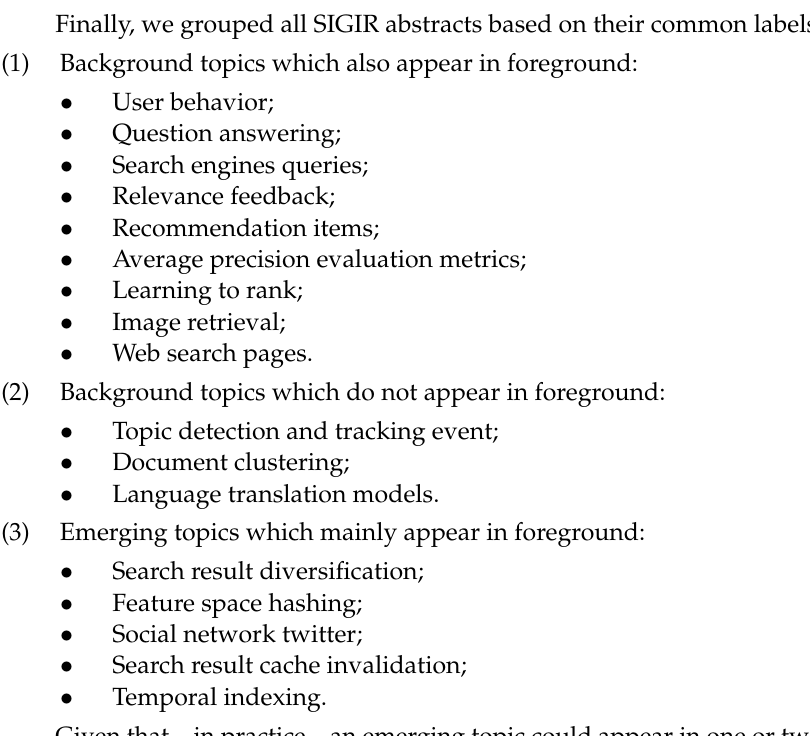
Figure 6. Distribution of ACM SIGIR 2000 – 2012 documents.